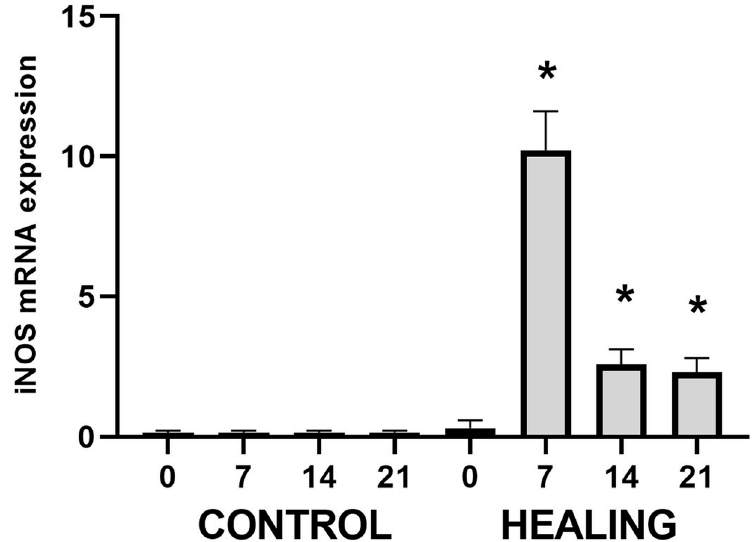
Figure 1- Kinetics of iNOS expression along the bone healing process and its correlation with M1 macrophages. Molecular analysis (Real-Time PCR Array) of iNOS mRNA expression kinetics along the bone healing process in C57Bl/6 mice. Results were obtained when comparing the relative expression of iNOS in the different groups normalized by Gapdh, Actb, and Hprt1; * represents the differences (p<0.05) between healing sites and the control group at each time